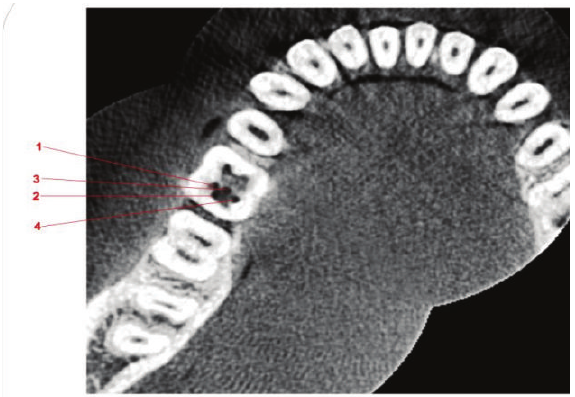
Figure 2: Enlarged CBCT axial section at the coronal one-third showing four distal and two mesial root canals, 1-distobuccal I, 2- distobuccal II, 3-middistal, and 4-distolingual.